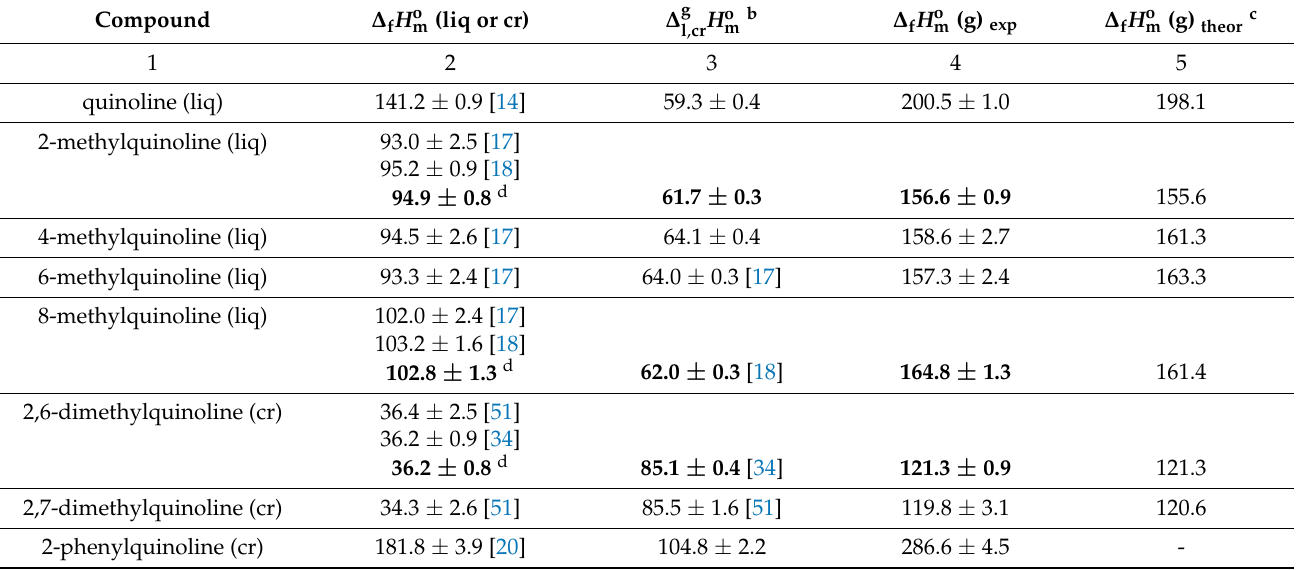
Table 9. Thermochemical data for quinolines at T = 298.15 K ( p ◦ = 0.1 MPa, in kJ · mol − 1 ) a